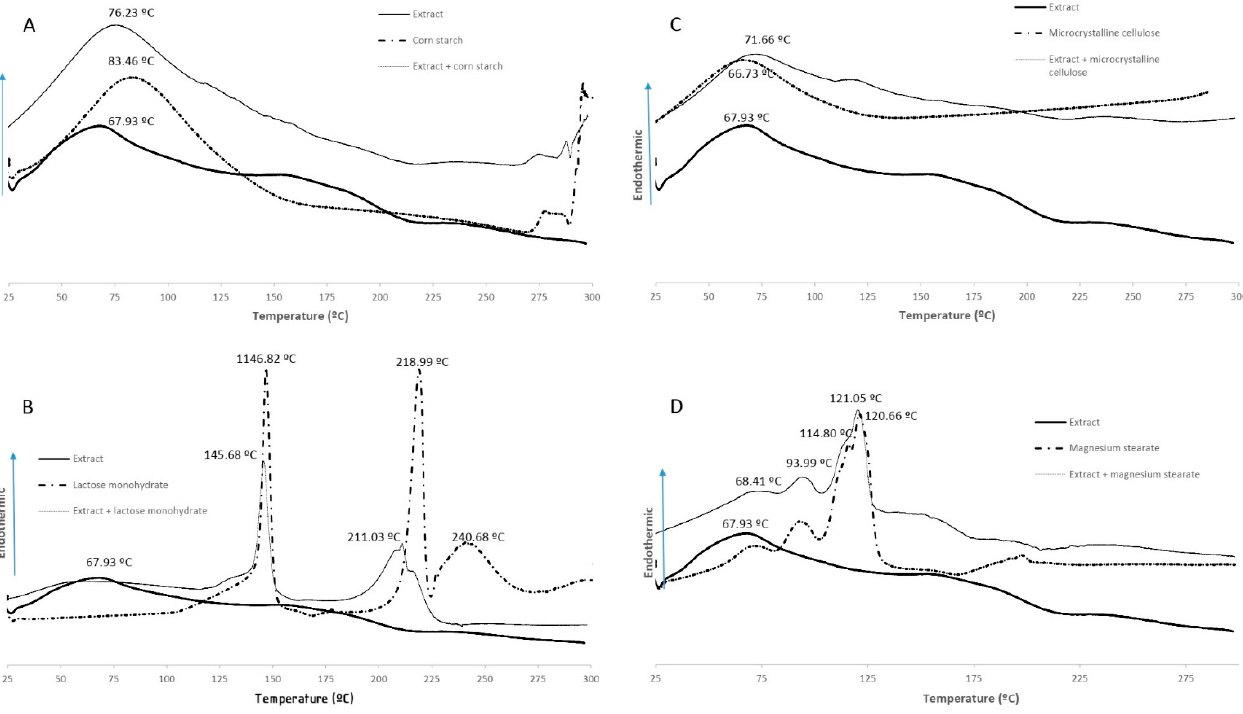
Figure 2. DSC thermograms of the extract, excipients and extract–excipients mixtures (1:1): ( A ) corn starch; ( B ) lactose monohydrate; ( C ) microcrystalline cellulose; ( D ) magnesium stearate.